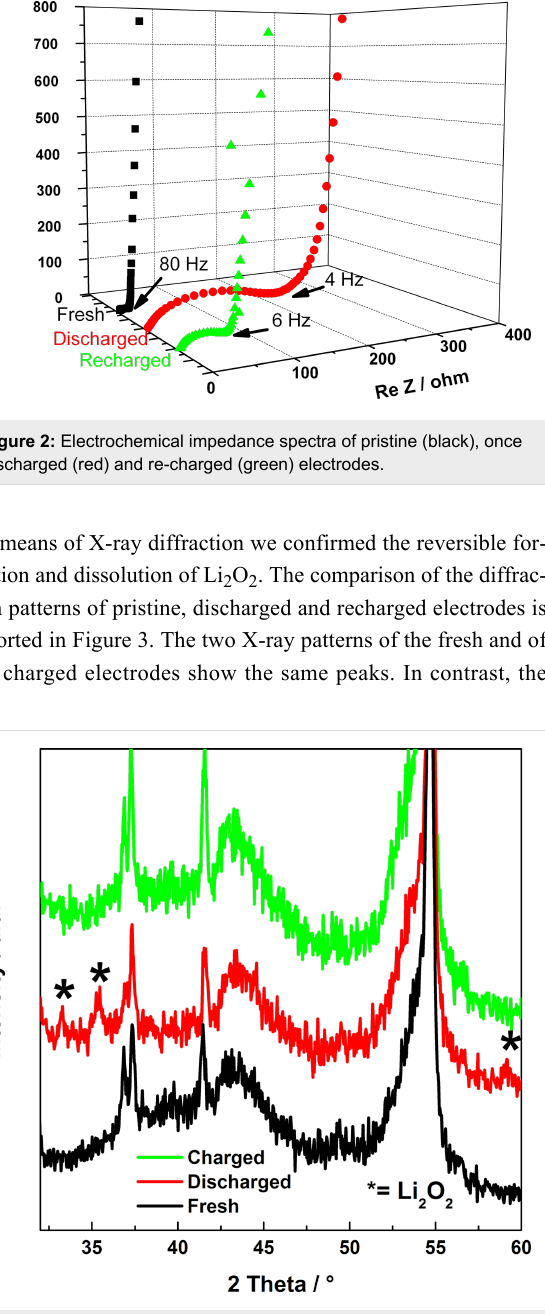
Figure 3: X-ray diffractograms of pristine, discharged and charged carbon cathodes. Note the additional peaks of Li 2 O 2 (marked by asterisk) for the discharged state of the cathode.